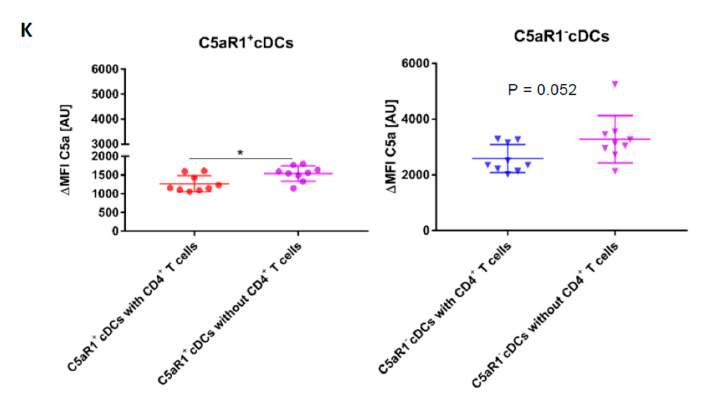
Figure 8. Impact of OVA-pulsing and T cell co-culture on C5 production and C5a generation from C5aR1 + and C5aR1 − cDCs. ( A , F ) Histograms showing C5 production ( A ) or C5a generation ( F ) in C5aR1 + or C5aR1 − cDC subsets directly after FACS purification on day 0, after OVA-pulsing on day 1 or after addition of OVA-tg CD4 + T cells on day 2; grey histogram = FMO control. ( B , G ) Frequency of C5-producing ( B ) or C5a-generating ( G ) C5aR1 + (left panel) or C5aR1 − cDCs (right panel). ( C , H ) Comparison of the frequencies of C5-producing ( C ) or C5a-generating ( H ) C5aR1 + and C5aR1 − cDCs on days 0, 1 and 2. ( D , I ) Quantitative evaluation of C5 production ( D ) or C5a generation ( I ) in C5aR1 + (left panel) or C5aR1 − (right panel) cDCs on days 0, 1 and 2. ( E , J ) Comparison of C5 production ( E ) or C5a-generation ( J ) in C5aR1 − or C5aR1 + cDCs on days 0, 1 and 2. The data shown in D, E, I and J